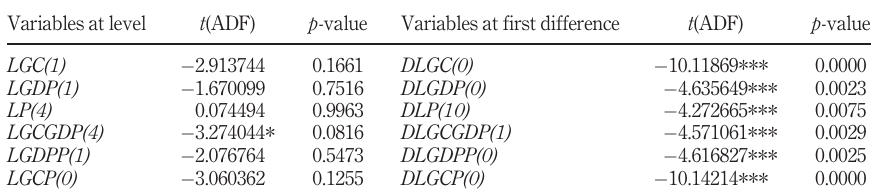
Table 3. ADF unit-root